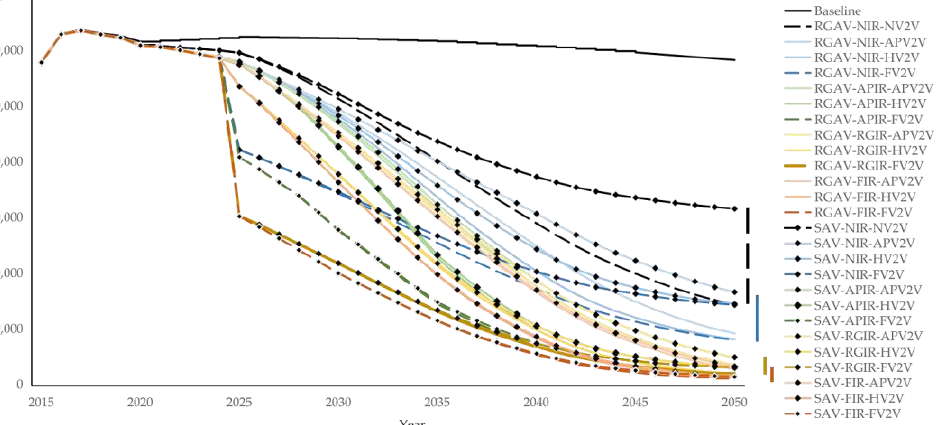
Figure 3. Annual road fatalities for 26 scenarios. Annual road fatalities are summarized in each AV scenario (RGAV, SAV), IR scenario (NIR, APIR, GRIR, and FIR), and V2V scenario (NV2V, APV2V, HV2V, and FV2V) combination, which appear in 27 lines. The symbol represents each AV scenario, with the color representing the IR scenario and the depth of color representing the V2V scenario.